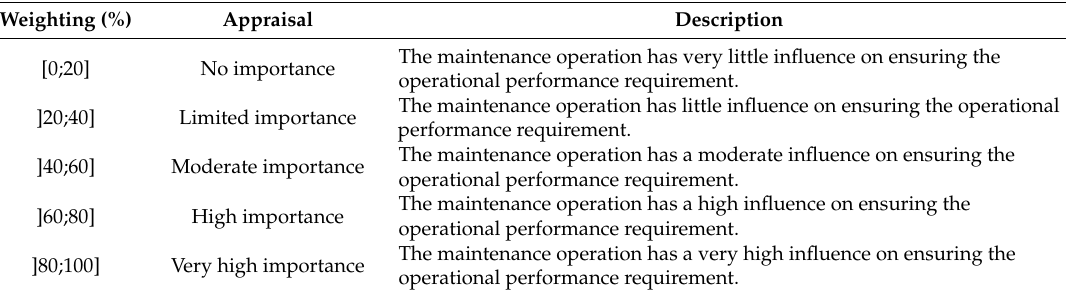
Table 1. Evaluation of the importance indicator (Iid).